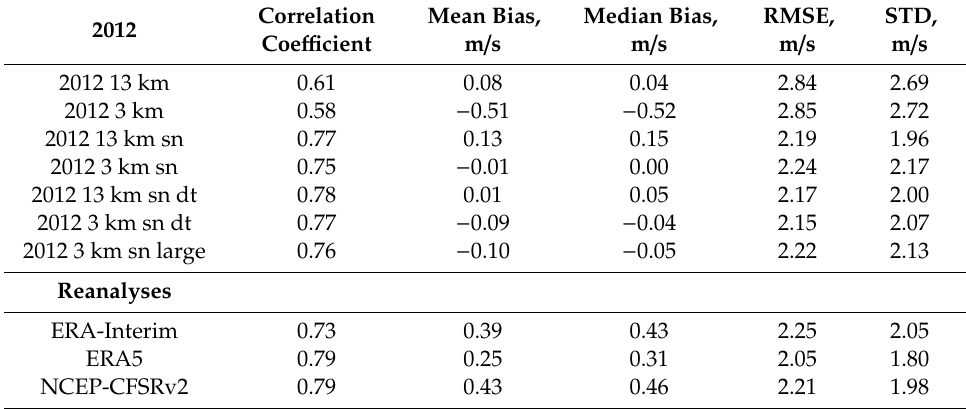
Table 1. Statistical scores of experiments verification results for the September–October 2012 period, 10 m wind.